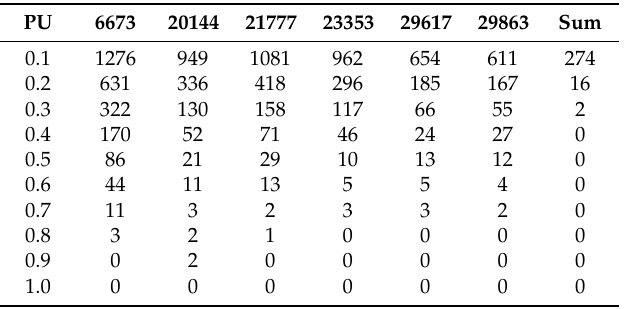
Table 2. Number of downward ramps in 1 h: Rocky Mountains